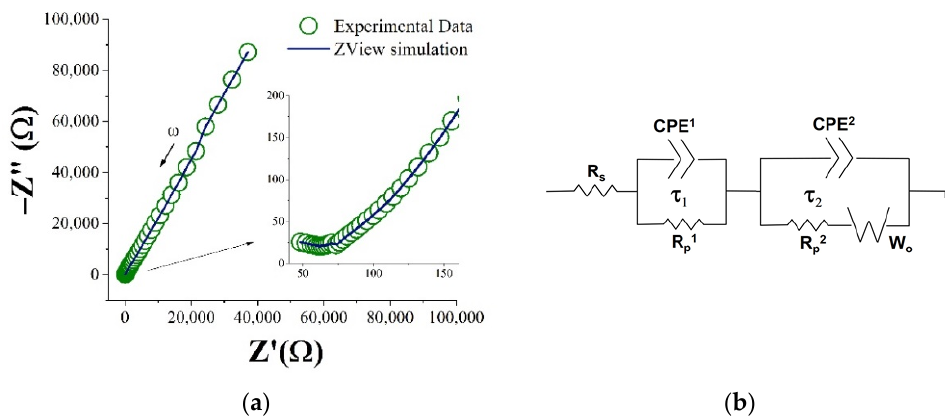
Figure 6. Typical EIS data obtained for samples: ( a ) Nyquist plot and ZView simulation; ( b ) equivalent circuit.